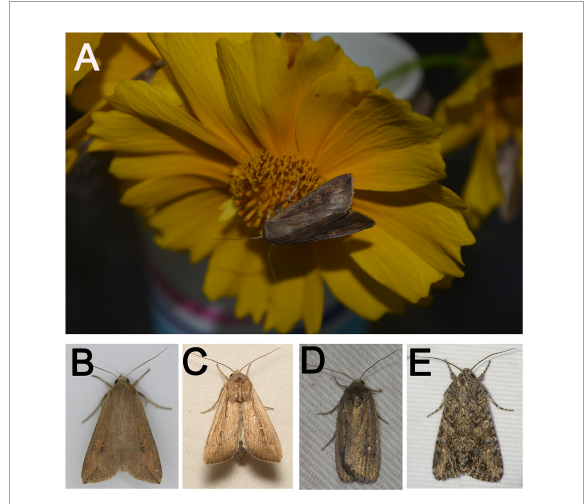
FIGURE1 Representative images of noctuid moths used in the study (A) : Mythimna separata male adult, visiting flower and sucking nectar. (B) : M. separata female adult; (C) : Mythimna loreyi male adult; (D) : Athetis lepigone adult; (E) : Hadula trifolii adult). All images were taken by Limei He and Shengyuan Zhao with Nikon D5100 (A) and Canon EOS 60D (B-E) .